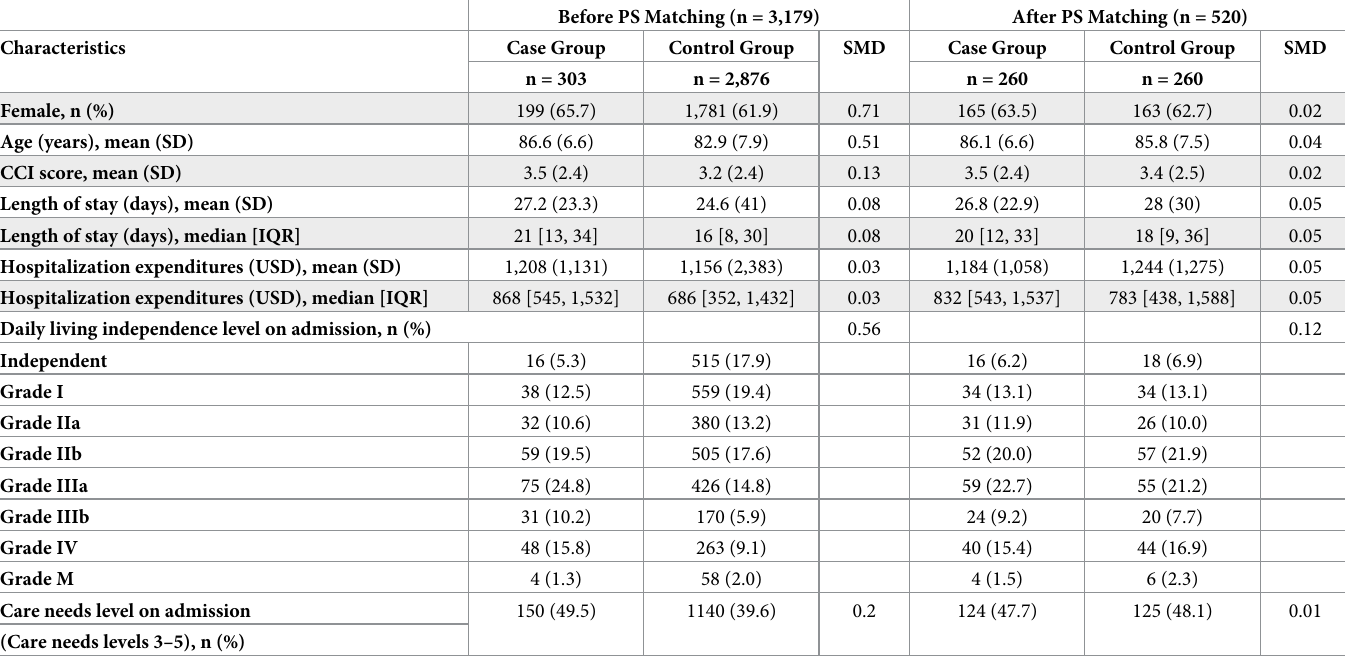
Table 1. Patient characteristics before and after PS matching.